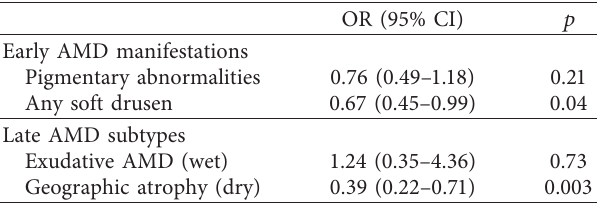
Table 5: Multivariate-adjusted ORs for AMD subtypes in relation to long-term RASI treatment among RASI